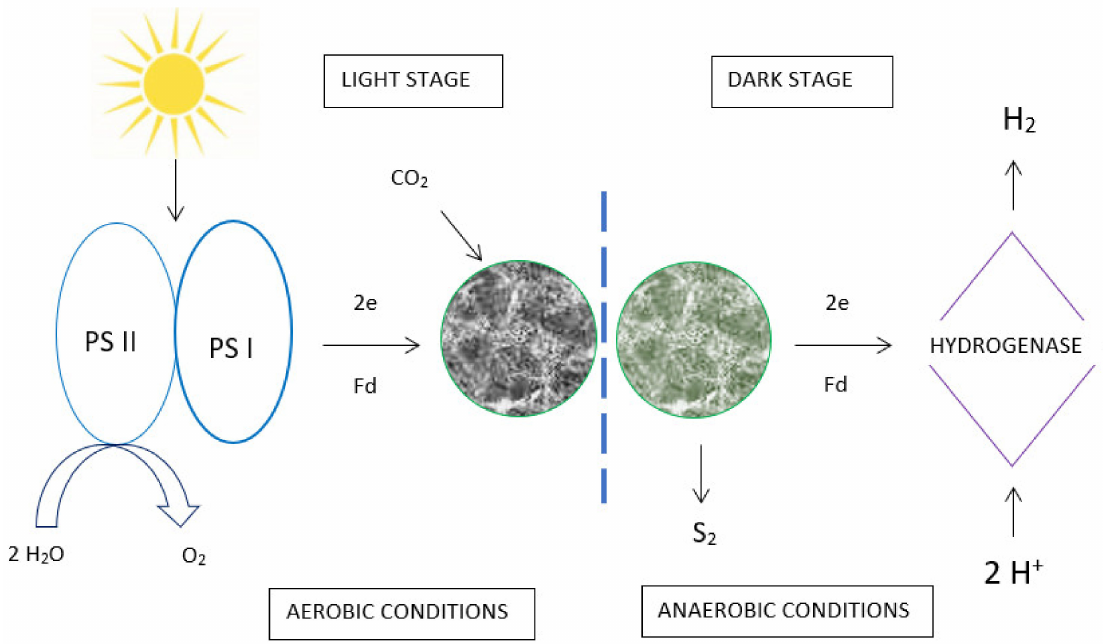
Figure 3. Diagram of direct water